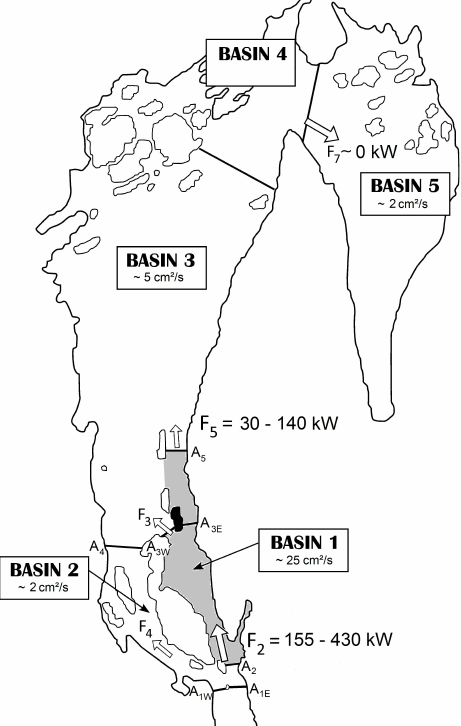
Fig. 13. Fluxes F of internal wave energy entering and leaving the area just north of the Drøbak Sill (highest and lowest values from Table 4) are shown in a schematic map of the inner Oslofjord. The results from calculations at stations S2 and S5 are indicated with the highest and lowest result next to the arrows. The depth-averaged dif- fusivities (Eq. 22) between 90 and 125m depth with unit cm 2 s − 1 are indicated for Basin 1, 2, 3 and 5. The area of increased turbu- lence production is shaded (between S2 and S5). The Aspond Island is marked with black. The cross sections from Table 3 are marked on the